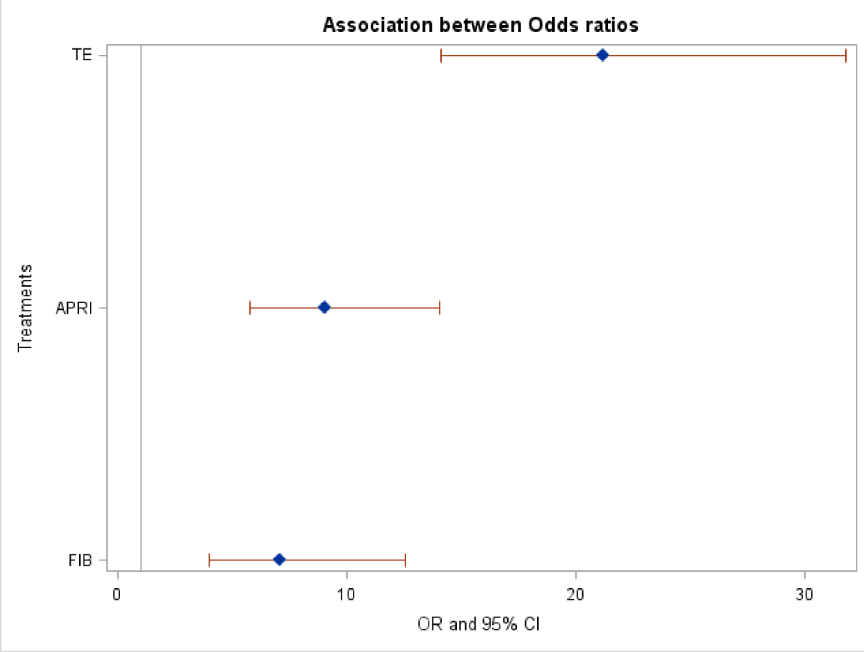
Fig 5. Direct comparison of diagnostic accuracyof non-invasive tests. There was no significant difference betweenAPRI and FIB-4 (P > 0.05), but there was a significantdifference betweenTE and FIB-4 (P < 0.05)and betweenTE and APRI (P < 0.05).